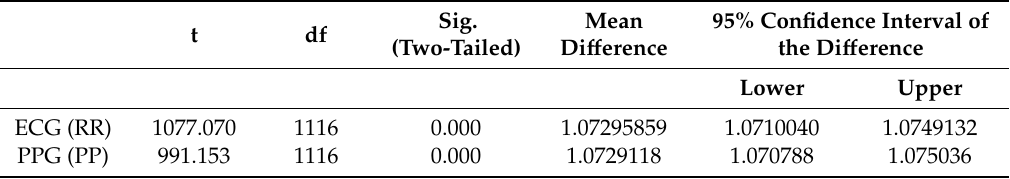
Table 1. One-sample Table 1. One ‐ sample test.